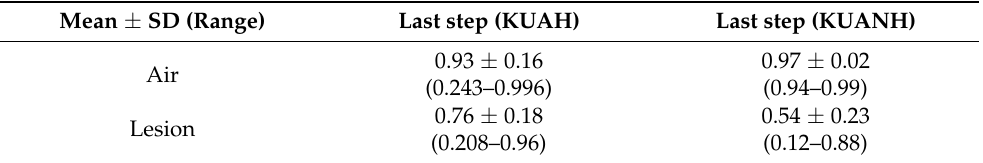
Table 3. DSCs for the test dataset (20 cases of internal-KUAH and 20 cases of external-KUANH) in Figure 1; 3D-nnU-Net.